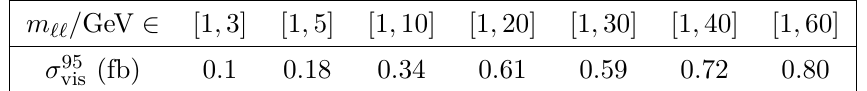
√ analysis at s = 13 TeV [91]. σ 95 T vis